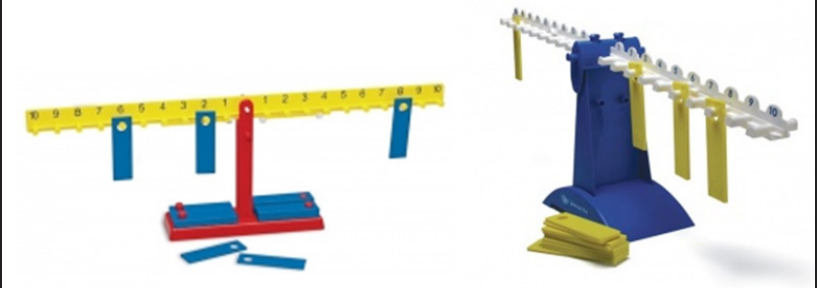
Figure 8: Scales help to develop an understanding of the ‘=’-sign The ‘+’ sign is introduced with the help of the ‘number house’, which the children already know from the ‘finding an order’ exercises.